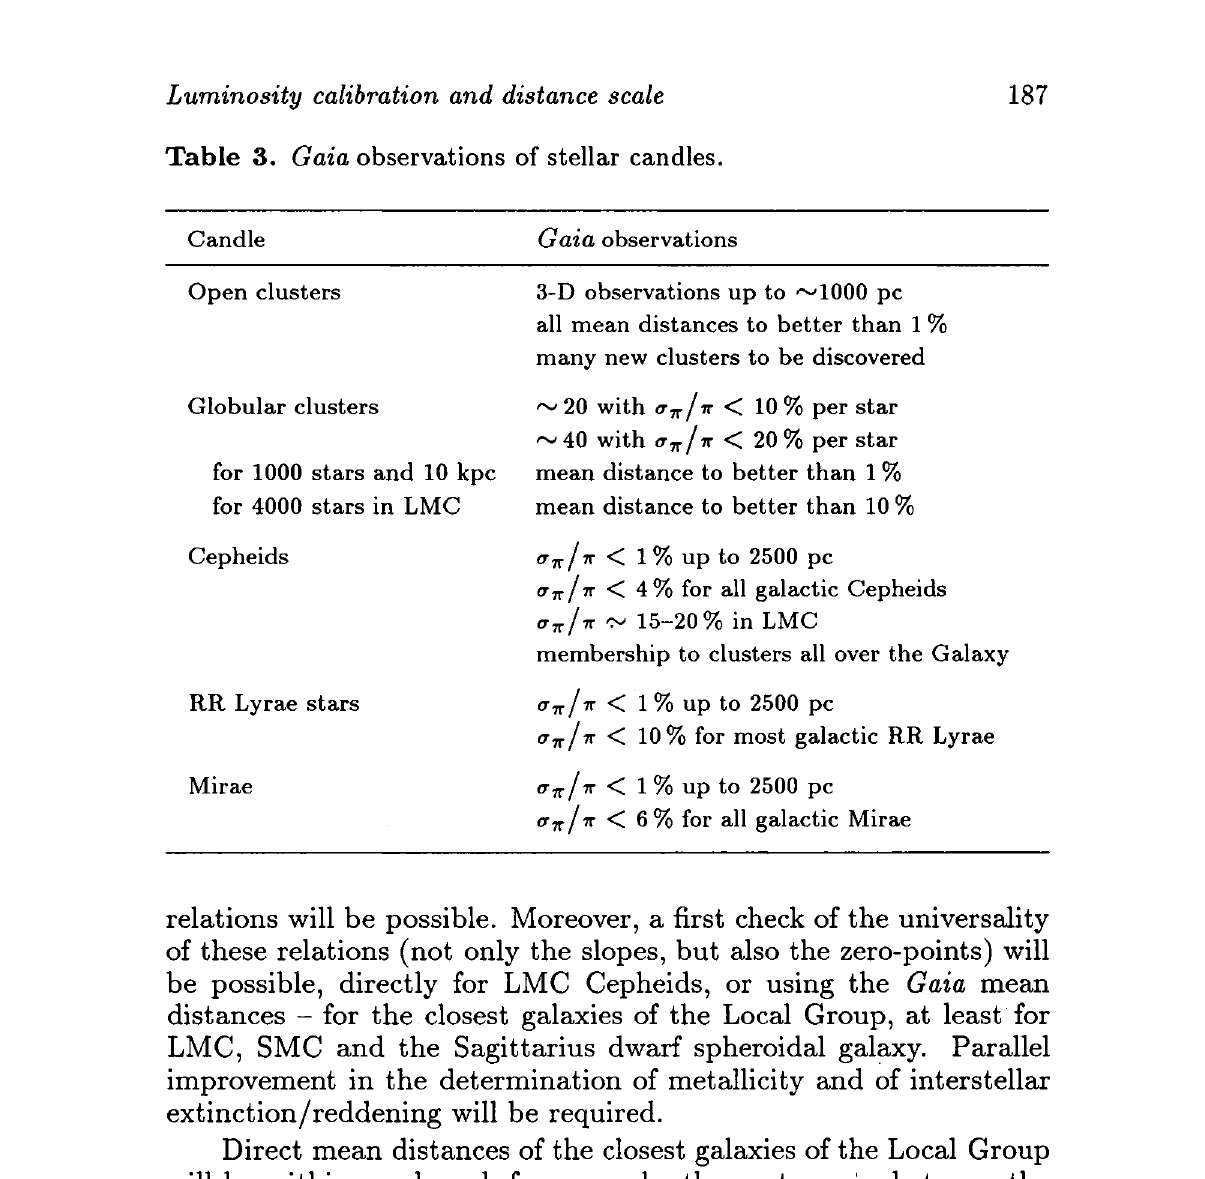
Table 3. Gaza observations of stellar